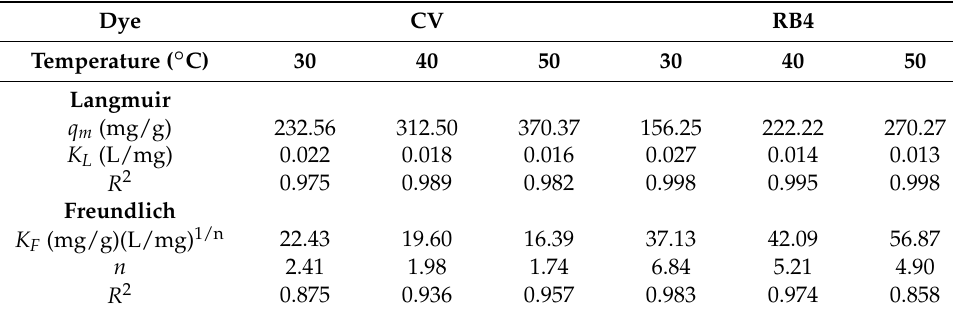
Table 2. Isotherm parameters for dye adsorption onto hydrogel beads.